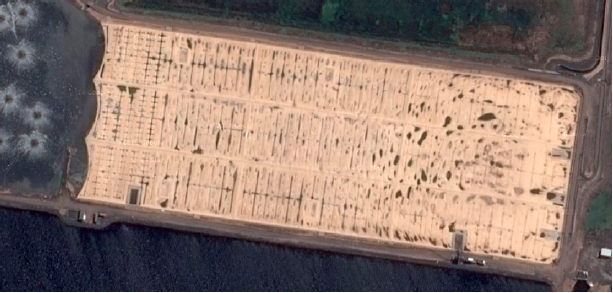
Figure 1. Aerial view of floating cover at Melbourne Water’s Western Treatment Plant.